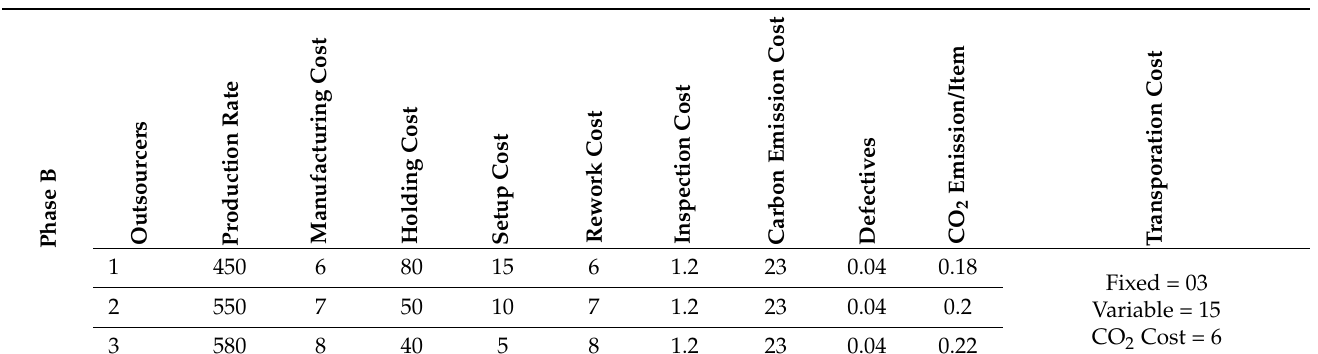
Table 6. Outsourcing